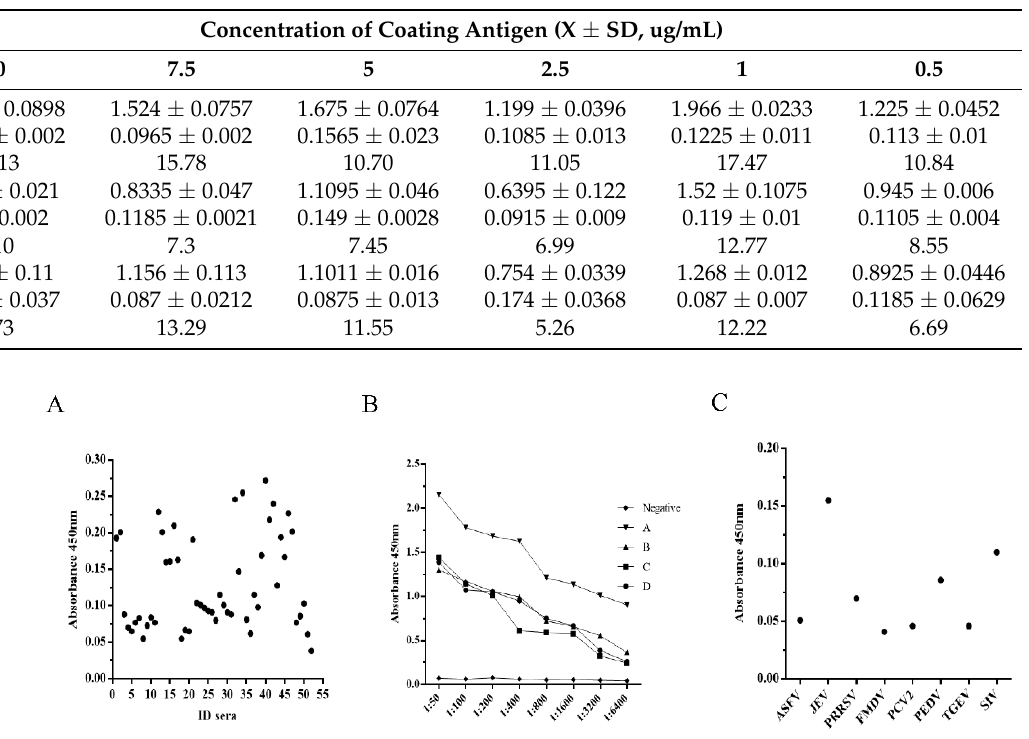
Table 1. Optimal sample dilutions and coating antigen for PPV-VLP-ELISA.